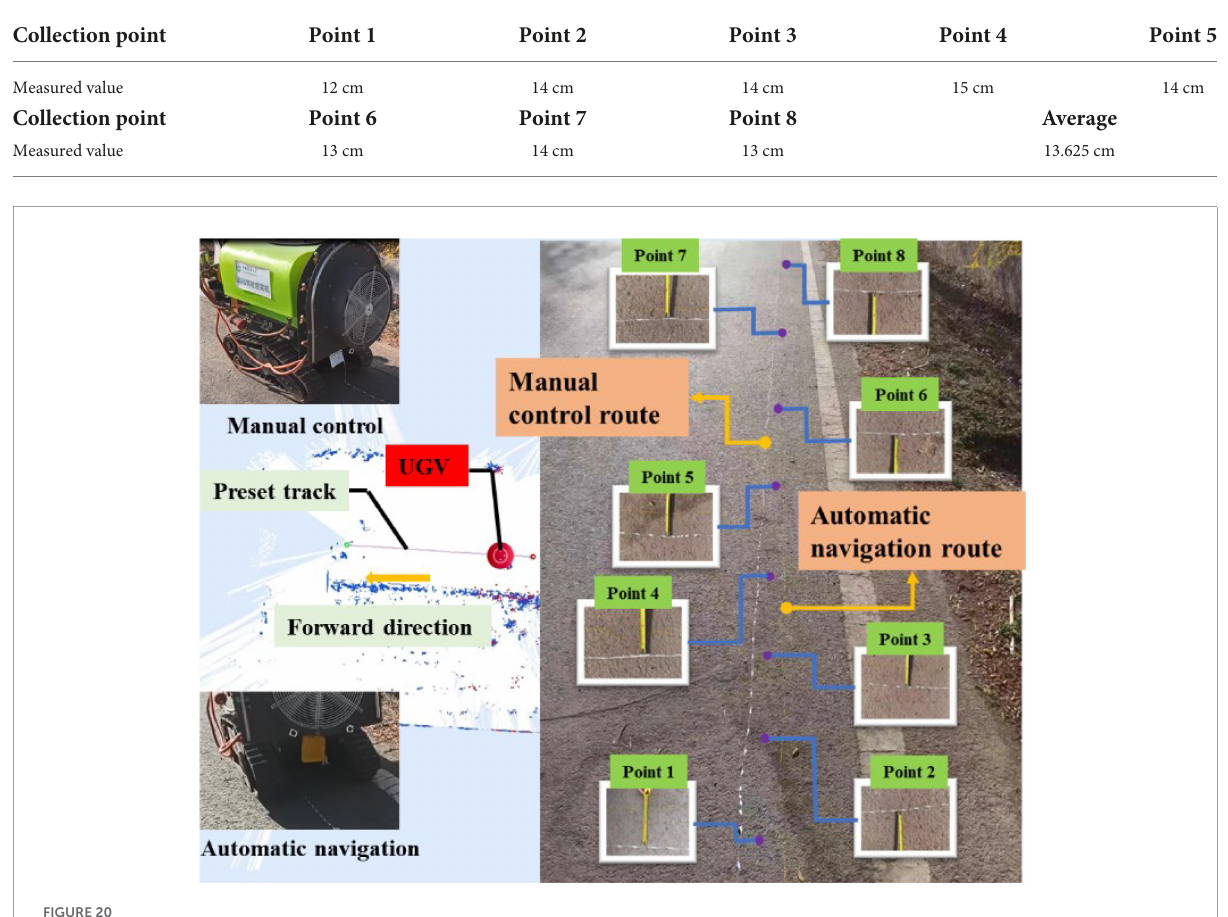
FIGURE20 Navigation accuracy experiment (Group